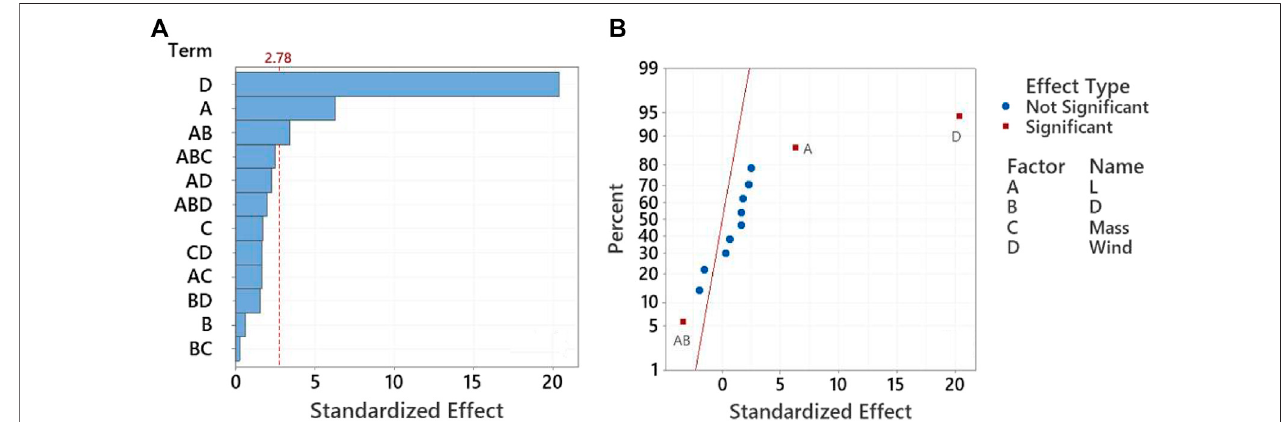
FIGURE 10 | Pareto chart (A) and normal plot (B) for the full factorial tests with ABCD, ACD, and BCD terms removed.